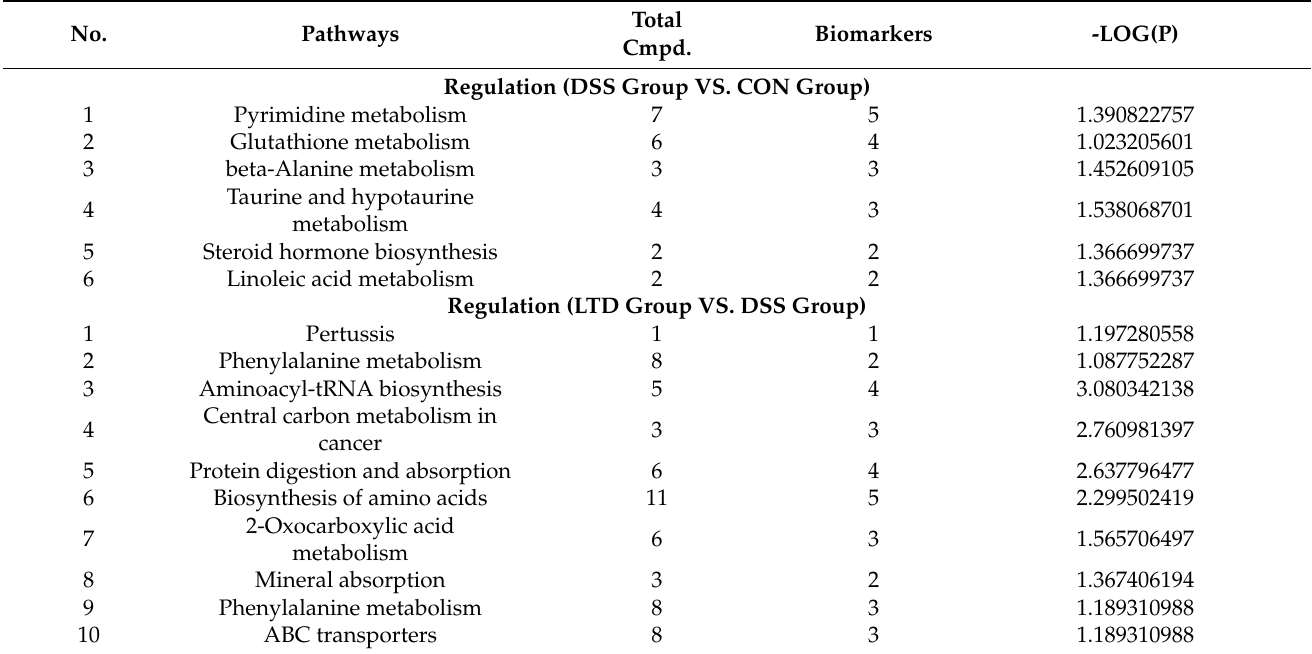
Table 3. The regulation of metabolic pathways in IPEC-J2 cells in CON, DSS and LTD groups ( P value < 0.01).